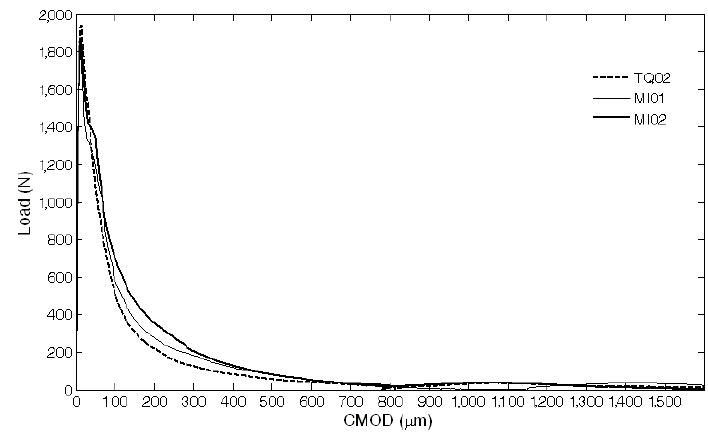
Figure 11. Load vs . CMOD curves for control specimens (TQ series and MI series) resulting from pre-loading and re-loading stages.